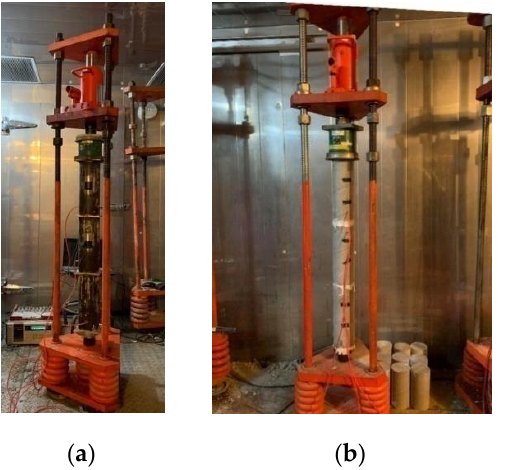
Figure 3. Setup for creep test with loading frame: ( a ) CFT specimens, ( b ) SCC specimens.